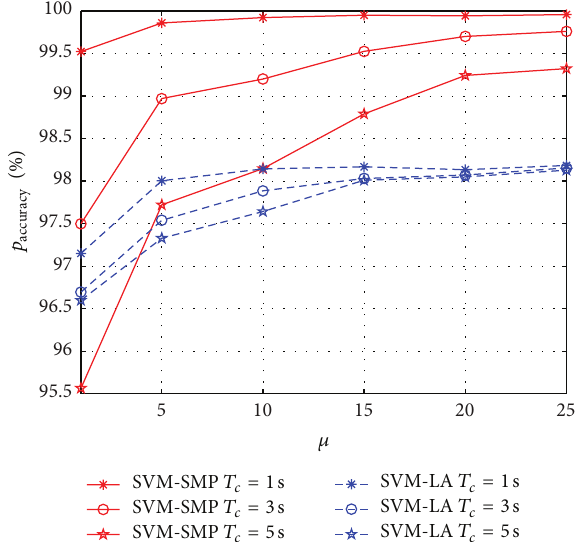
Figure 10: Prediction accuracy rate 𝑝